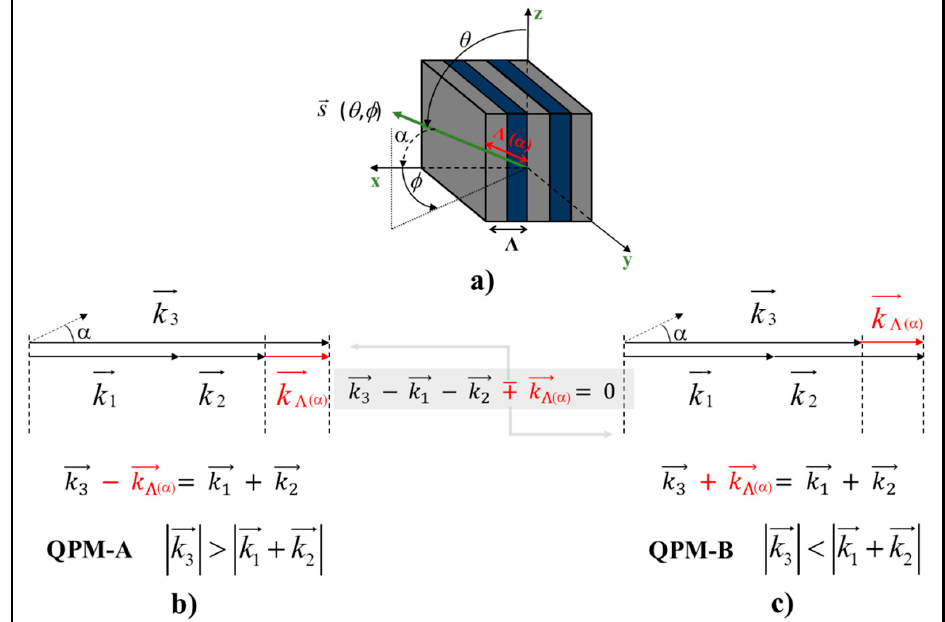
Figure 1. Collinear APQM configuration. ( a ) Scheme of the periodically poled medium with an inverting periodicity Λ and poled domain set to be orthogonal to the x -axis of the (x, y, z) dielectric frame of the medium. 𝑠⃗ is the unit vector of the propagation direction of the three interacting waves; θ and ϕ are the angles of spherical coordinates of the propagation direction ; α is the angle between the unit vector of the propagation direction 𝑠⃗ and the x-axis direction. k Λ ( α ) is the effective grating vector along the propagation direction; 𝑘 (cid:2869) (cid:4652)(cid:4652)(cid:4652)(cid:4652)⃗ , 𝑘 (cid:2870) (cid:4652)(cid:4652)(cid:4652)(cid:4652)⃗ and 𝑘 (cid:2871) (cid:4652)(cid:4652)(cid:4652)(cid:4652)⃗ are wave vectors of the interact-